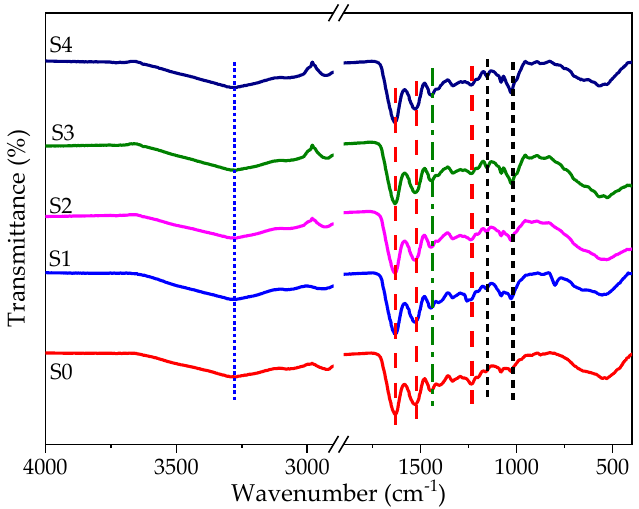
Figure 2. Fourier transform infrared spectroscopy (FTIR) spectrums of S0, S1, S2, S3 and S4.